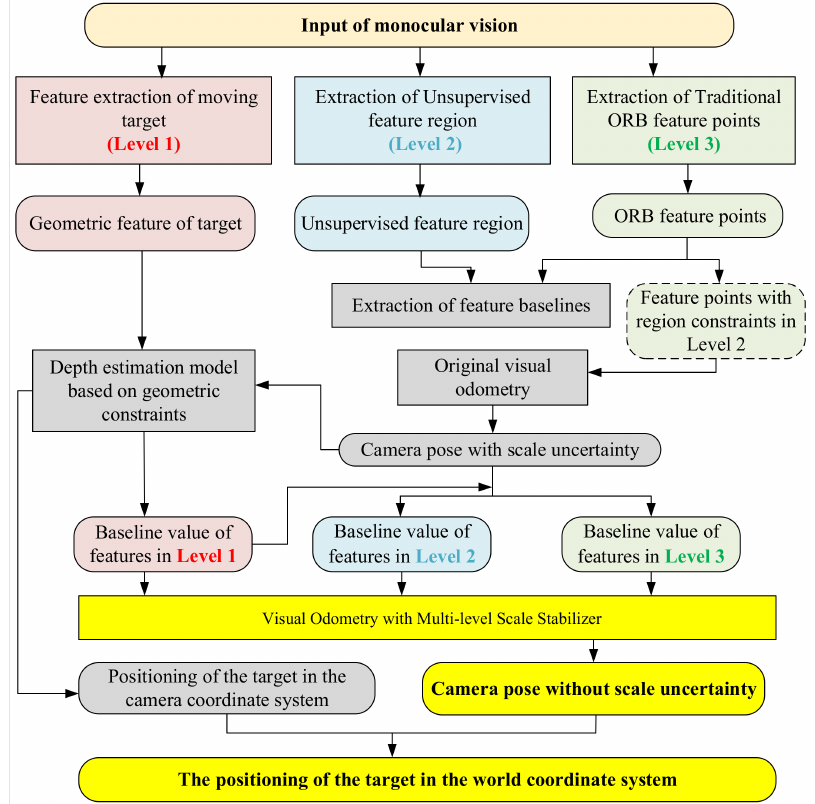
Figure 6. The overall research diagram showing data reduction